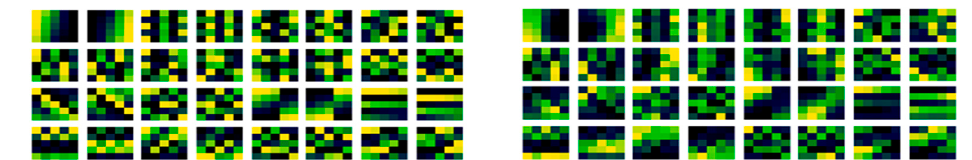
Figure 6. Initial and learned weights in the first conv layer with the proposed non-random method.